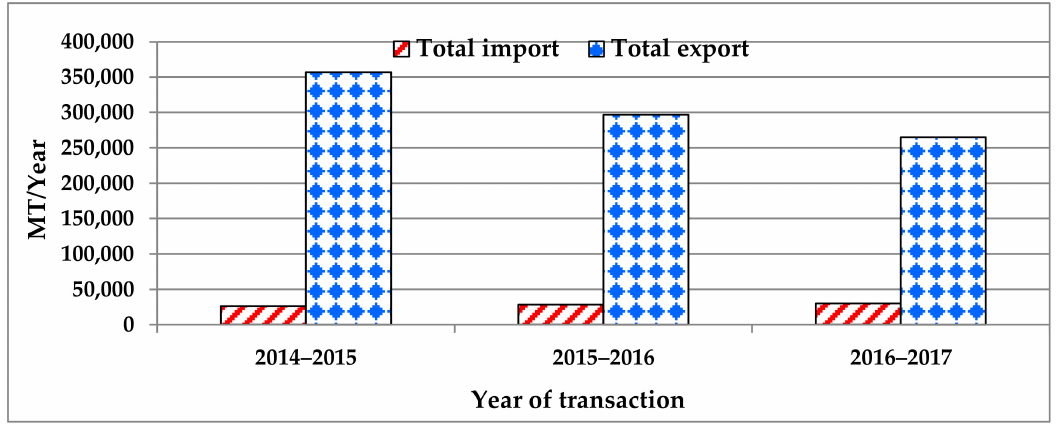
Figure 3. Total import and export of EU-28 of fresh peaches and nectarines during three